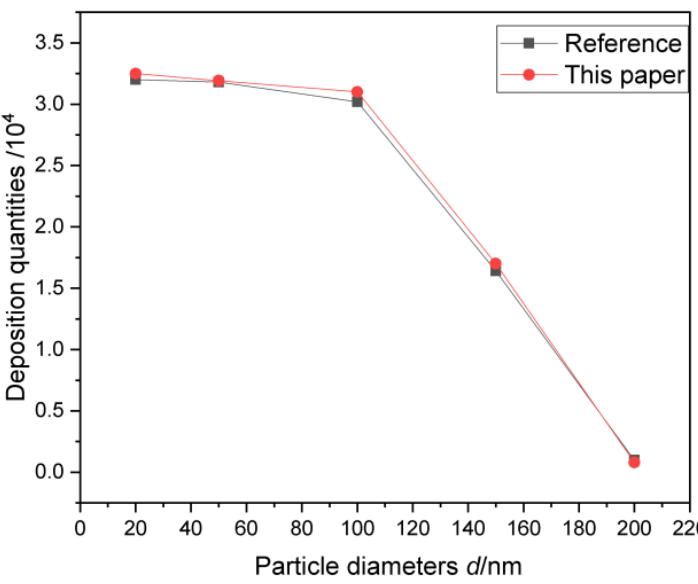
Figure 5. Comparison of simulation results of solid particle deposition.